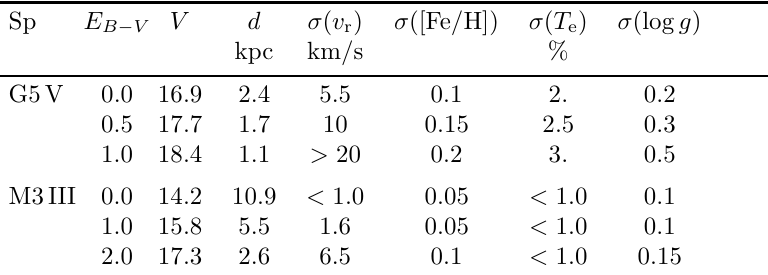
Table 1. Predicted accuracies for kinematical and astrophy- sical parameters of G5 V star ( M V = 5 . 0 ; TO tracer of 15 Gyr old population) and M3 III star ( M V = − 1 . 0 ; RGB/AGB tracer) as derived with Gaia . Data for each tracer type is given at V magnitude corresponding to σ π /π = 0 . 1